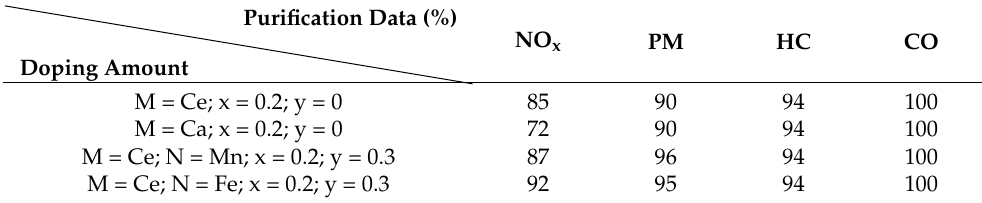
Table 3. The purification data for the best samples (x = 0.2; y = 0;